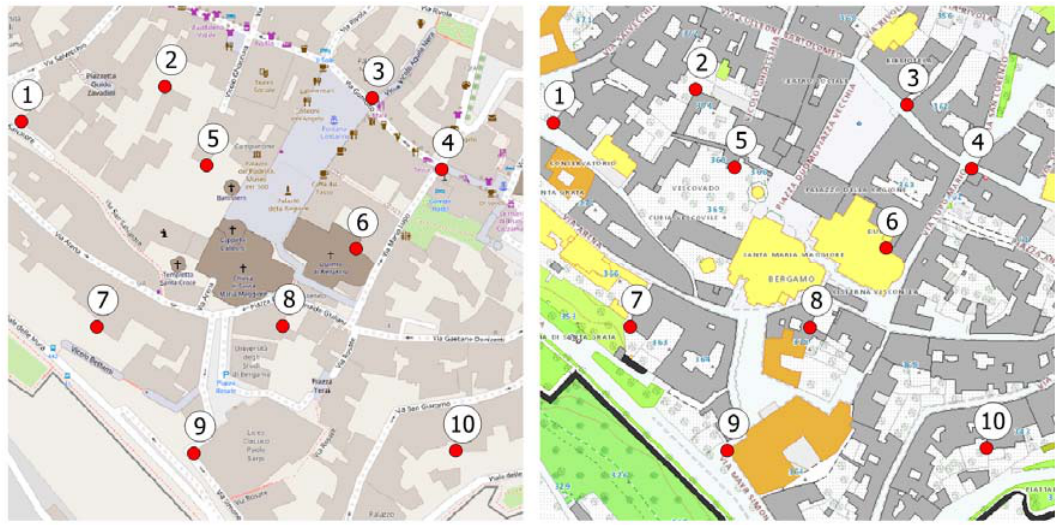
Figure 1. Example of homologous points on two different maps.